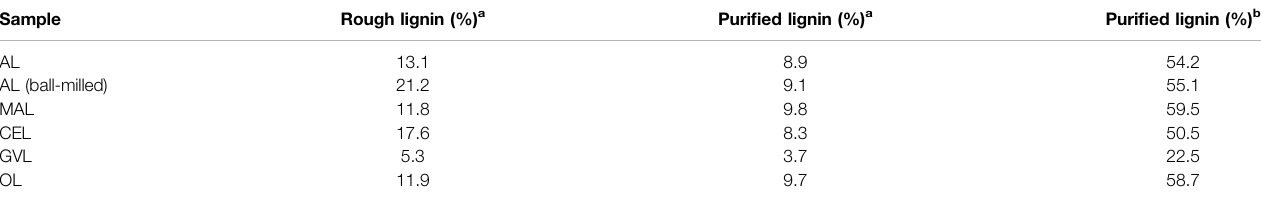
TABLE 1 | The yield of lignin by different extraction methods.